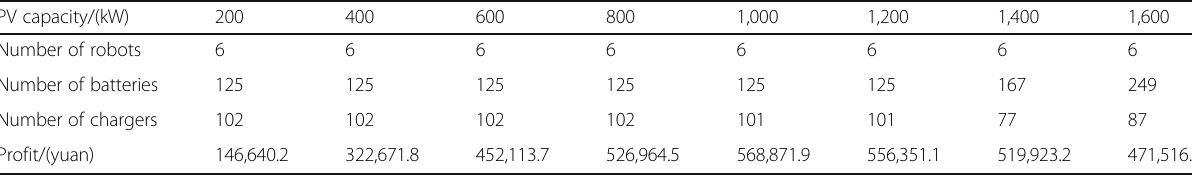
Table 5 The optimal configuration solutions of BSS with different PV capacities (PV bundling requirement = 80%) PV capacity/(kW)